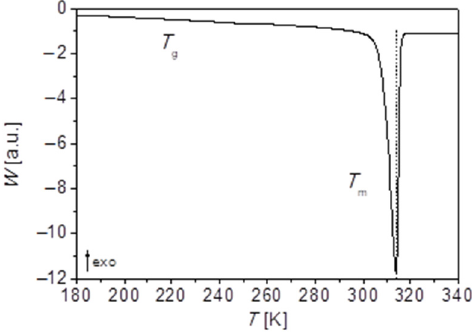
Figure 5. DSC thermogram for PEG-thy/dat obtained at a heating rate of 10 K·min − 1 , showing the glass transition ( T g ) temperature interval and the melting temperatures ( T m ) with increasing temperature, respectively as indicated by the dashed